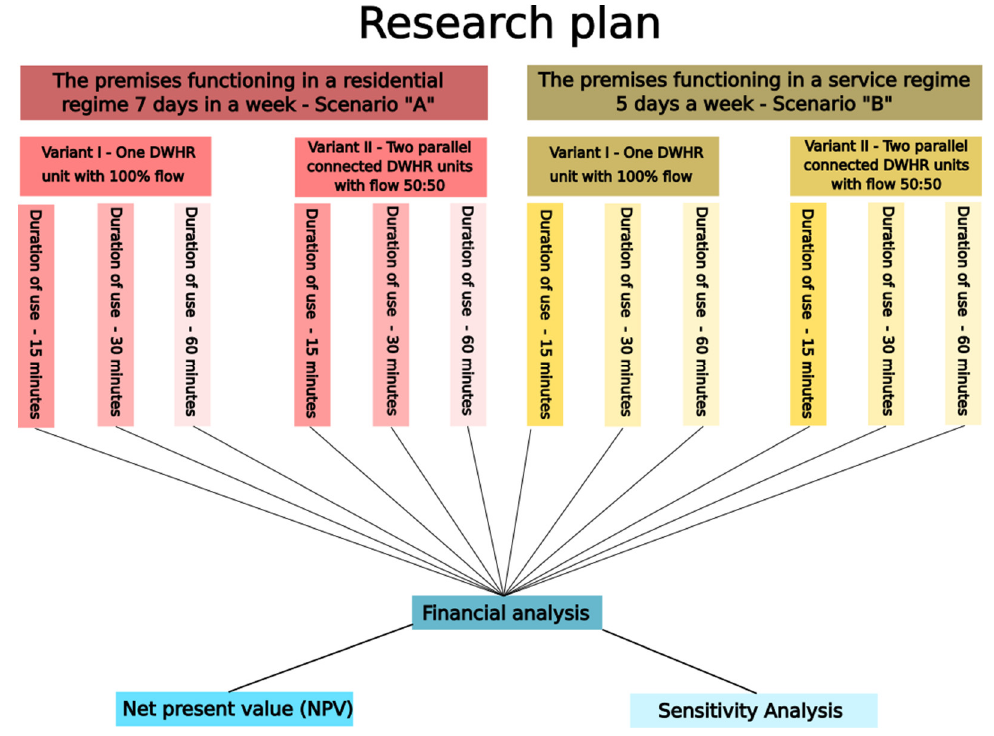
Figure 4. Research plan for HE_0 and HE_1.